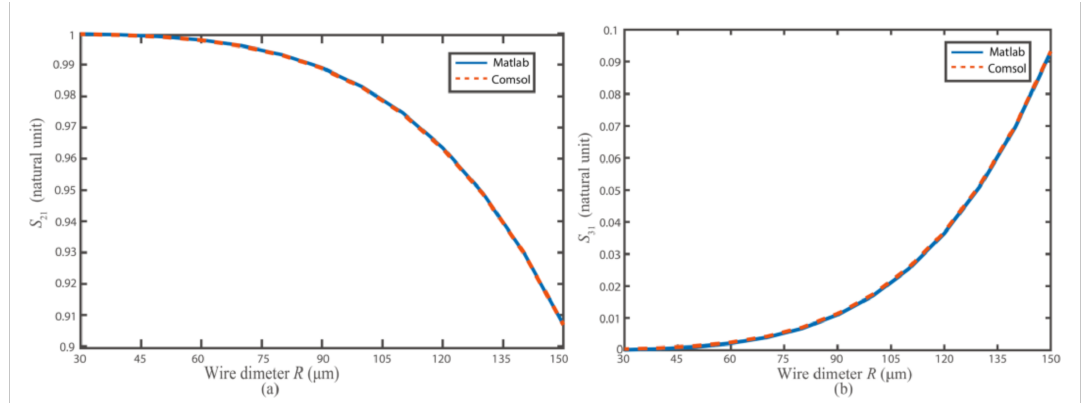
Figure 10. ( a ) Transmission ( S 21 ) and ( b ) reflection ( S 31 ) coefficients of Gaussian fundamental modes with the diameter of cylindrical wire R